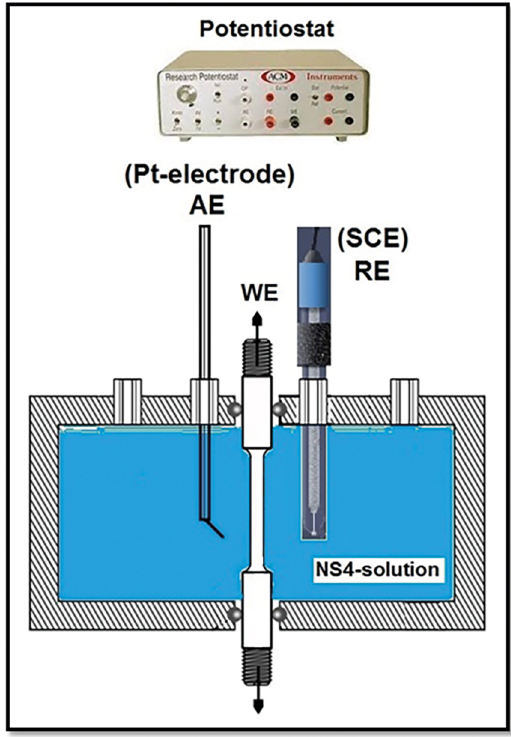
Figure 2. Experimental set up for electrochemical noise tests.